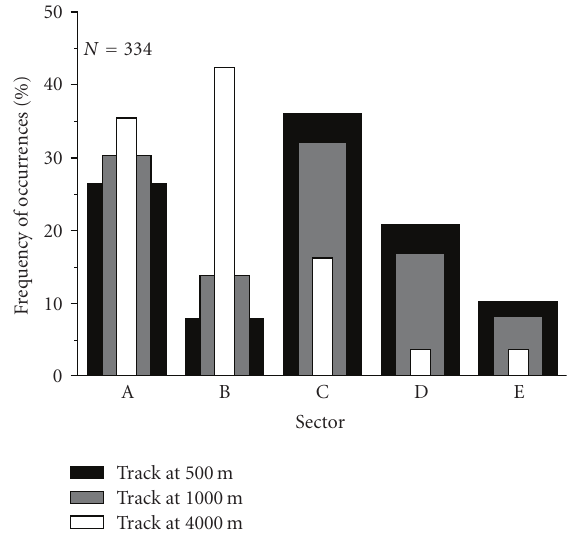
Figure 5: Same as in Figure 3, but for the DD aerosol type.